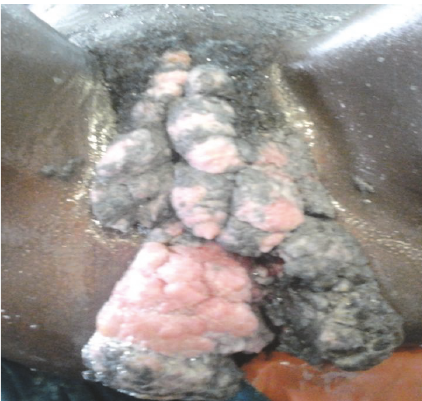
Figure 1: Giant condyloma acuminatum before surgical resection.